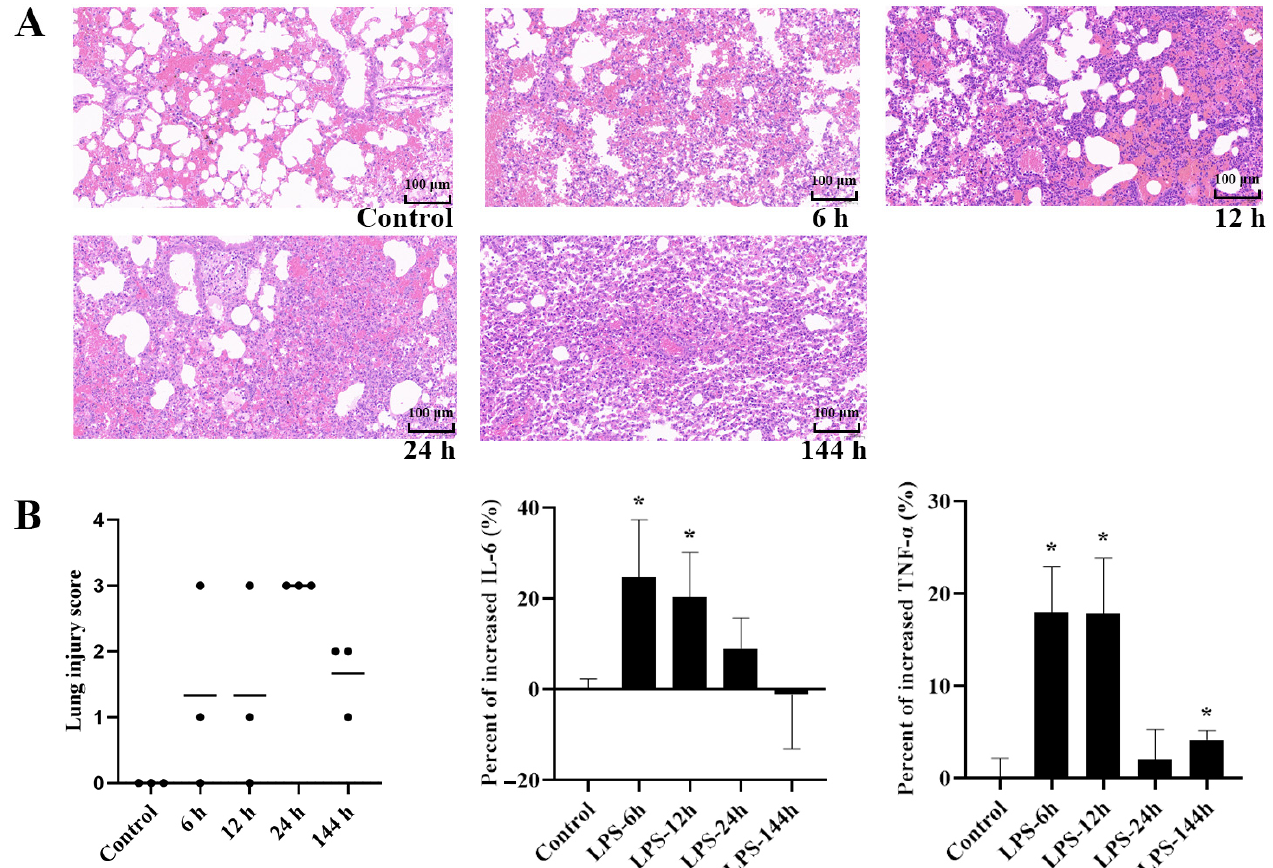
Figure 1. The lung inflammation and injury in LPS-induced ALI mice at different time points. ( A ) Histological image ( × 20) of lung sections with hematoxylin and eosin (H&E) staining. ( B ) Lung injury scores (from 0 to 4) of the lung sections and the increased levels of IL-6 and TNF- α ( n = 3, Mean ± SD, * p < 0.05 compared to the control group). Table 1. Pharmacokinetic parameters of TET in blood after a single i.v. administration in normal and LPS-induced ALI mice ( n = 6, Mean ±